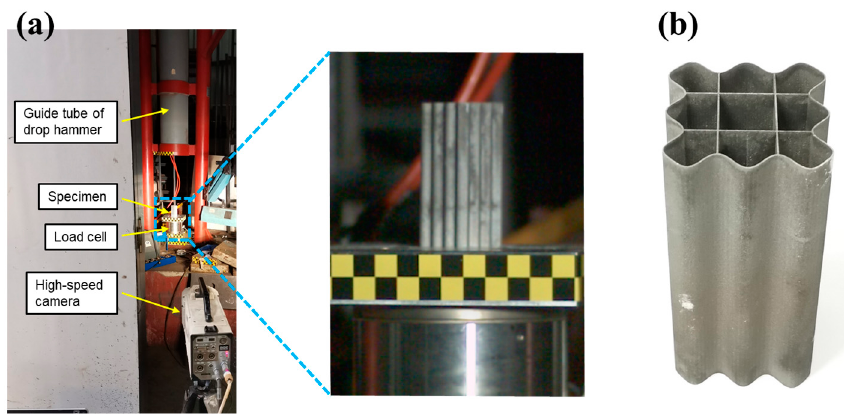
Figure 6. Drop hammer test for the MCCT: ( a ) test scene and ( b ) test tube.